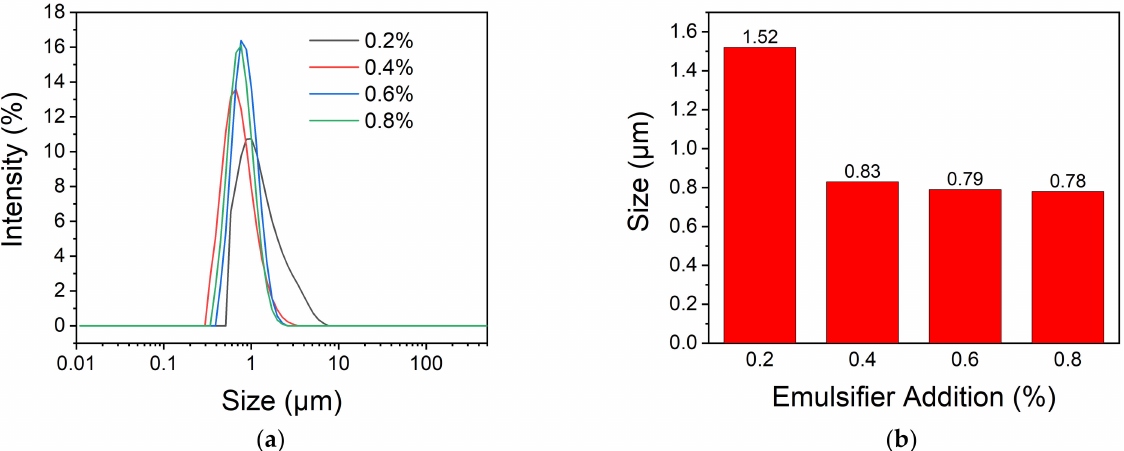
Figure 4. The size and size distribution of microcapsules prepared with different addition amount of emulsifier ( a ) and the average diameters ( b ).